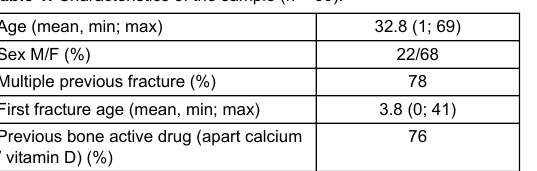
Table 1: Characteristics of the sample (n =